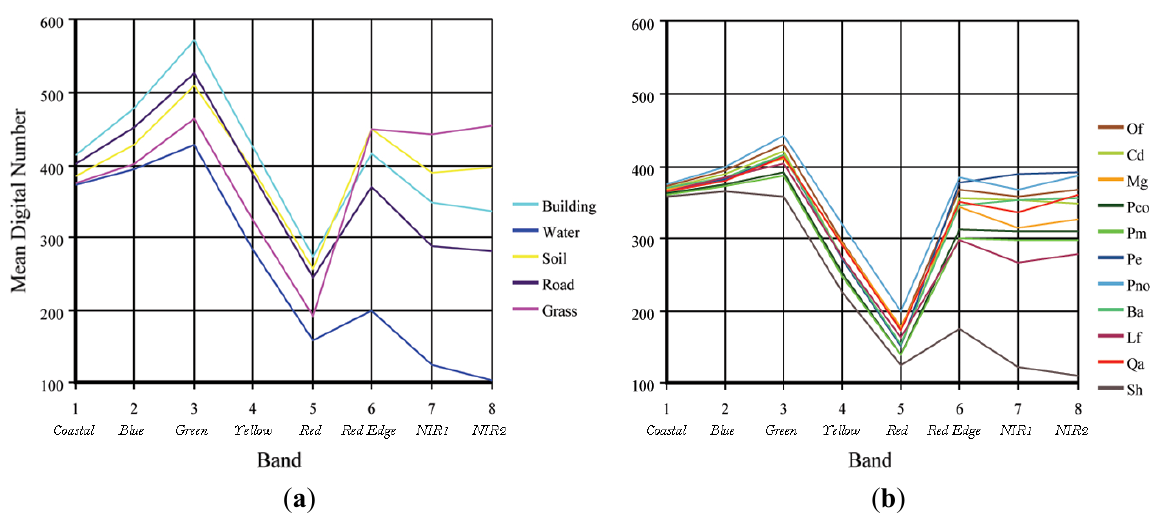
Figure 6. Comparison of the mean digital number (DN) values of different classes using a line chart. The abbreviations are the same as in Figure 5. ( a ) Non-forest area; ( b ) Forest area.